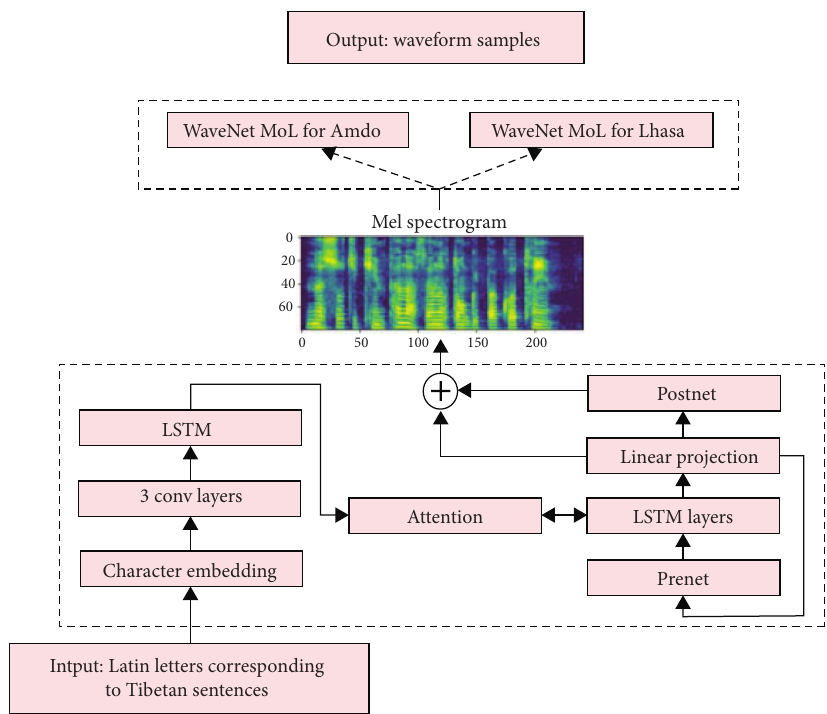
Figure 1: End-to-end Tibetan multidialect speech synthesis model.